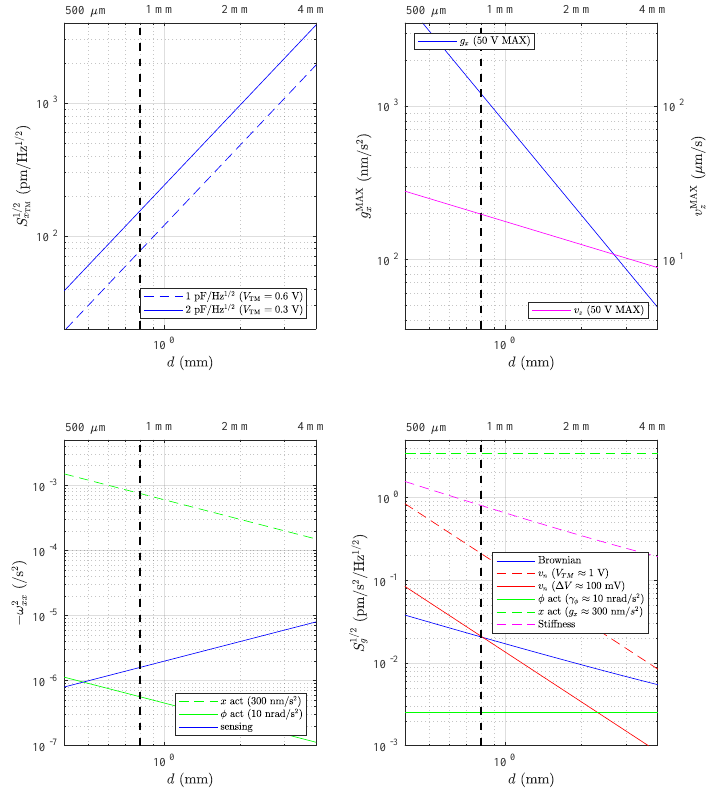
Figure 3. Key performance parameters for the studied GRS design as a function of the TM-EH gap d , assuming a cubic TM of side length s = 34 mm (reference design gap of 800 µ m is indicated with a vertical dashed black line). ( Top left ) Displacement sensing “white noise” performance for fixed levels of capacitive sensing noise S ∆ C . ( Top right ) Maximum x actuation force and maximum allowed TM z velocity allowing to stop the TM at no more than half the sensor Z gap. ( Bottom left ) Main sources of force gradient or “stiffness”. ( Bottom right ) Simple scaling of several known key TM acceleration noise sources evaluated at 1